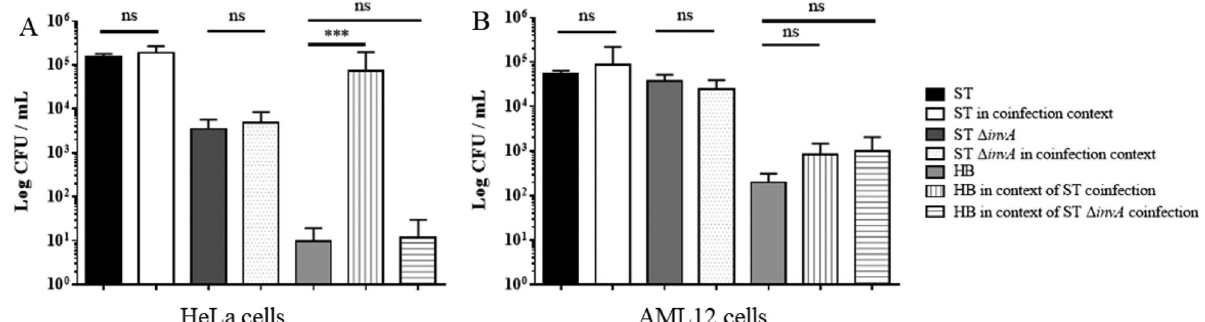
Figure 5. Salmonella Typhimurium vacuole maturation was mostly macropinosome independent in murine AML12 cells. HeLa cells ( A ) and AML12 cells ( B ) were grown in 24-well plates. Infection of cells was carried out for 60 min in 300 µL medium without serum at MOI 50 with ST or ST Δ invA alone or coinfected with the E. coli HB101 strain transformed with pSUP202, allowing for chloramphenicol selection. To quantify invasion, after 60 min of infection, cells were washed, and gentamicin protection assays were performed consisting of three washes with medium followed by 60 min in medium with 100 µg/mL gentamicin. After this, cells were extensively washed and lysed, and serial dilutions were plated on TSA and TSA chloramphenicol. Co-invasion was estimated by subtracting growth observed on TSA chloramphenicol to growth on TSA. The black bar corresponds to ST invasion without coinfection, the white bar ST invasion in coinfection context, the dark grey bar ST Δ invA invasion without coinfection, the dot bar ST Δ invA invasion in coinfection context, the light grey bar E. coli HB101 invasion without coinfection, the vertical line bar E. coli HB101 invasion in ST coinfection context, the horizontal line bar E. coli HB101 invasion in ST Δ invA coinfection context. Data are the means and standard deviations from three independent experiments. Statistical analyses using a Mann Whitney test were performed. Significance was (***) p = invasive in HeLa cells and is a weakly invasive strain in AML12 cells (Supplementary Fig. 2). Our coinfection experiments had no impact on Salmonella invasion on either cell model. However, in HeLa cells, E coli HB101 invasion was significantly ( p = 0.0002) increased when cells were coinfected with ST but not with ST Δ invA (Fig. 5A). This result can be explained by the fact that membranous perturbations induced during a trigger mechanism are associated with macropinocytosis inducing entry of a non-invasive strain in cooperation with an invasive strain 27 . On the other hand, in AML12 cells, E coli invasion was not increased in coinfection assays with ST or ST Δ invA , (Fig. 5B). Therefore, unlike in HeLa cells, this demonstrates that Salmonella invasion in AML12 cells is not associated with macropinocytosis. In AML12 cells, Salmonella Typhimurium 14028 resides intracellularly, mainly in a vacu‑ ole. We then wished to determine where Salmonella is capable of replicating consecutively in a T3SS1-inde- pendent invasion. Indeed, cytosolic Salmonella constitutes a significant proportion of the total bacterial popula- tion in several epithelial cell models 20 . Over time, we followed the replication of S. Typhimurium in AML12 cells with or without chloroquine, as this molecule has been shown to kill intravacuolar Salmonella 20 . Compared to 1h post-infection (pi), we found that there were 2.76 and 2.62 times more bacteria at 7 h pi for the ST and ST Δ invA strains, respectively. Our results show that without chloroquine, the ST and ST Δ invA strains were able to survive and slightly multiply inside AML12 cells during the duration of the experiment. In contrast, a 95% reduction in the number of these two strains was observed when chloroquine was added (Fig. 6A). These results support the idea of an intravacuolar localization of S. Typhimurium in AML12 cells at 7 h pi, leading to a multiplication rate about 10 times for ST and ST Δ invA at 16 h pi (Supplementary Fig. 2 and Fig. 1). To confirm bacterial localiza- tion, we performed a TEM analysis at 7 h pi on AML12 cells infected with ST or ST Δ invA strains, treated or not with chloroquine. In the absence of chloroquine, we observed the presence of intact bacteria only in vacuolar space (Fig. 6B,C); bacteria appeared as expected damaged or degraded in vacuoles when cells were exposed to chloroquine (Fig. 6D,E). This confirmed the intravacuolar localization of Salmonella in AML12 cells. To further investigate this observation of vacuolar residence of Salmonella in AML12 cells, we compared the localization of Salmonella in HeLa and AML12 cells using a dual color reporter plasmid p4889 (P EM7 ::DsRed P uhp T ::sfGFP) with combined expression of constitutive DsRed and cytosolic GFP 28 . At each time point imaged, we easily identi- fied Salmonella that was found only in its SCV (red) for AML12 (Fig. C,D) and both cytosolic (red and green) (Fig. 7B) and vacuolar (red) for HeLa cells (Fig. 7A,B). We never observed cytosolic ST (Fig. 7C) or ST Δ invA (Fig. 7D) in AML12 cells. Altogether, these results demonstrate a vacuolar localization of S. Typhimurium in AML12 cells. Maturation of the Salmonella containing vacuole leads to Salmonella replication with Salmo- nella ‑induced filament formation. SCV maturation has been deeply scrutinized in T3SS1-dependent invasion models. It is widely accepted that it consists of three stages: early, intermediate and late 29 . To interpret SCV maturation after T3SS1-dependent invasion, we exposed AML12 cells to ST or ST Δ invA strains for 1 h. In this way, we investigated the recruitment of several host proteins as markers of the different stages 14,17,30 , as well as the formation of SIF-like structures and the acidification of the vacuole 18,31 . Following immunocytochemistry